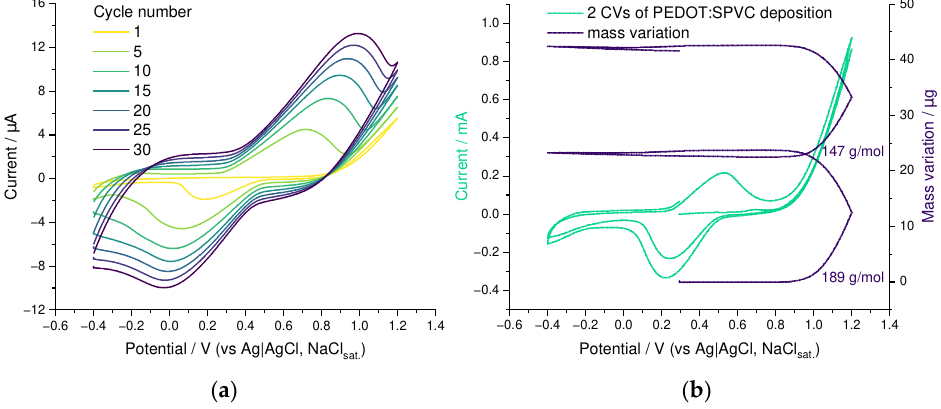
Figure 2. ( a ) CV and ( b ) EQCM curves for electrochemical oxidation of 10 mM EDOT + 10 mM NaSPVC, 20 mV·s −1 , 20% CH 3 CN in H 2 O.